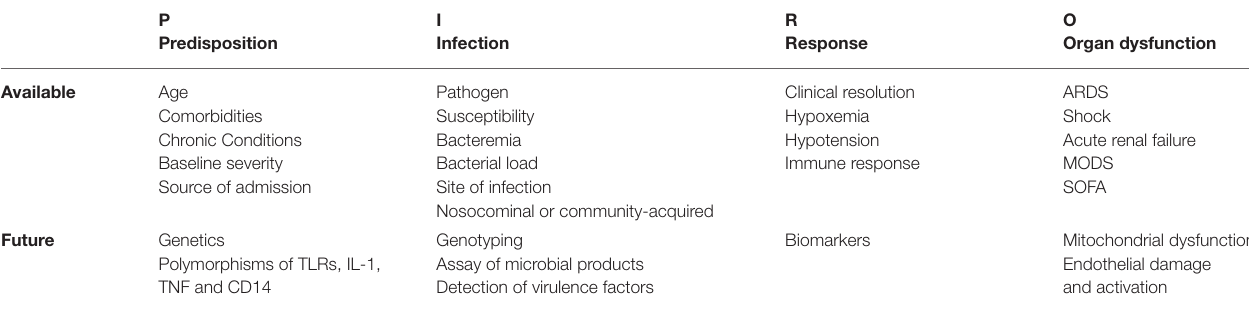
TABLE 4 | P I R O (sepsis patient staging